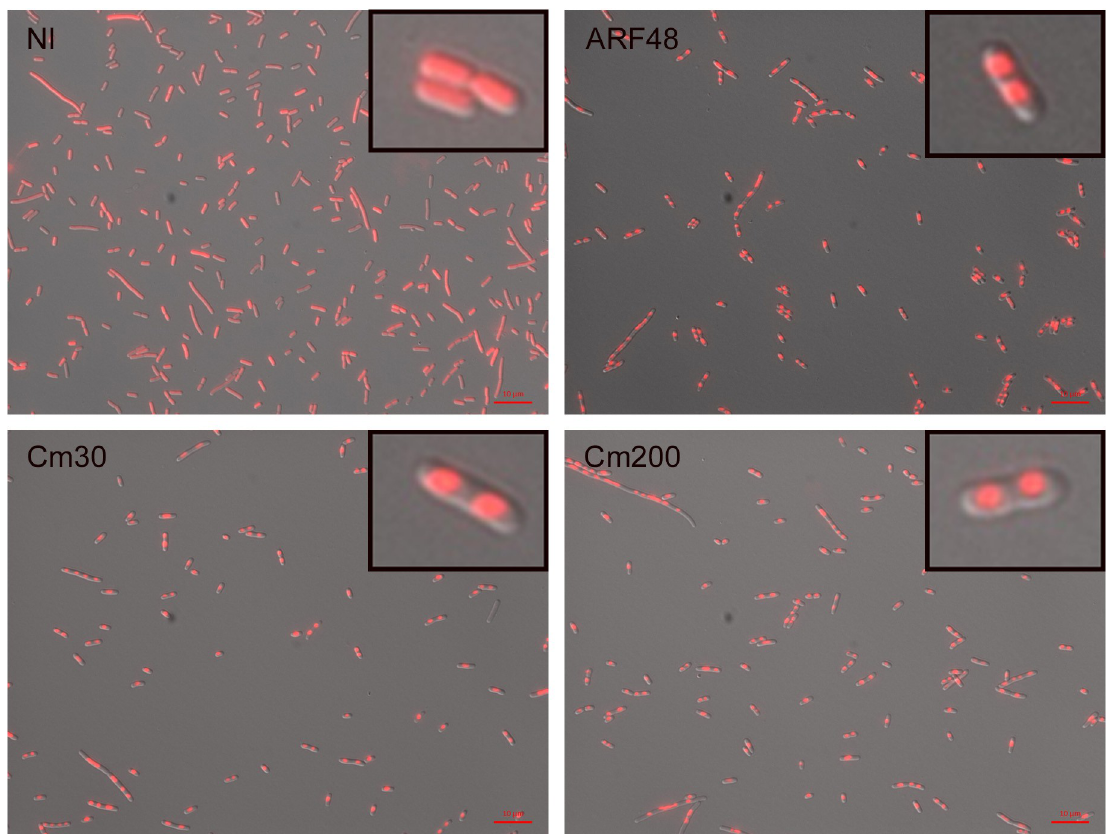
Fig 6. ARF48 increases cell uptake of Hoechst 33342 and induces radial condensation of nucleoids. An early log phase culture of BL21 cells transformed by pARF48 was divided and treated either with anhydrotetracycline (aTc; 0.2 μ g/ml) to induce ARF48 expression or with 30 or 200 μ g/ml Cm. At 10 min after ARF48 induction or 60 min after treatment with Cm, cell samples were stained with H33342 and examined by fluorescence microscopy. Exposure times were automatically set by camera software and were 0.22 s for ARF48 and Cm samples and 1.7 s for a sample of non-induced (NI) culture grown in parallel. Scale bar, 10 μ m. Results shown are representative of multiple independent